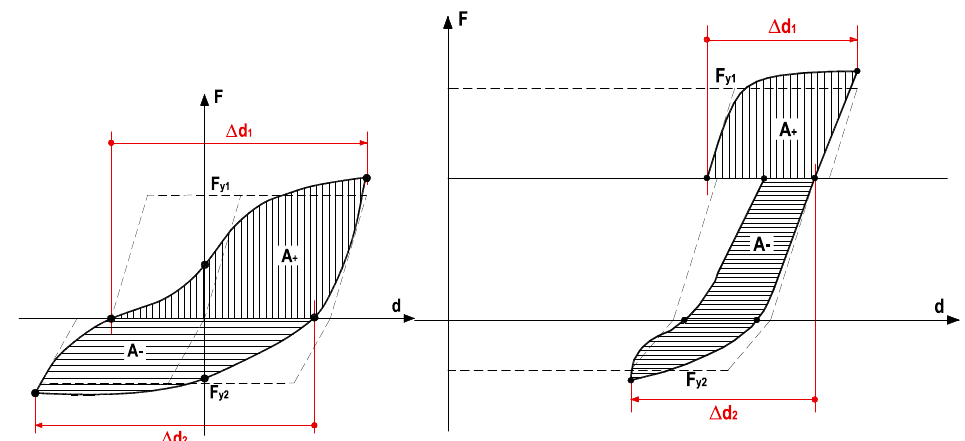
(3) In Figure 15, the absolved energy parameter versus ductility for Specimens S1 (a), S2 (b), and S3 (c) is presented. It should be mentioned that the negative ( − ) and positive (+)